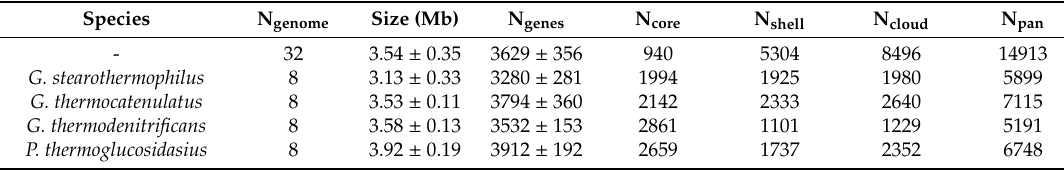
Table 1. Genomic statistics and pan-genome information of all